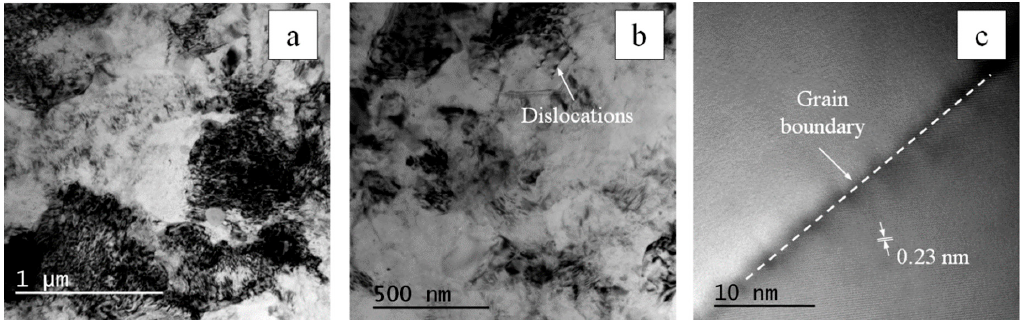
Figure 9. TEM image of the foil ( a , b ) prepared from the initial sample. The contrast in the micrograph corresponded to the contours of grain boundaries and other features (deformations, defects, and changes in thickness) of the sample. The characteristic grain size of the material was from hundreds of nanometers to a few microns. High-resolution image of aluminum grain boundary ( c ). The contrast of planes (111) of the aluminum crystal lattice is visible. Table 2. The properties of composites in powder and bulk